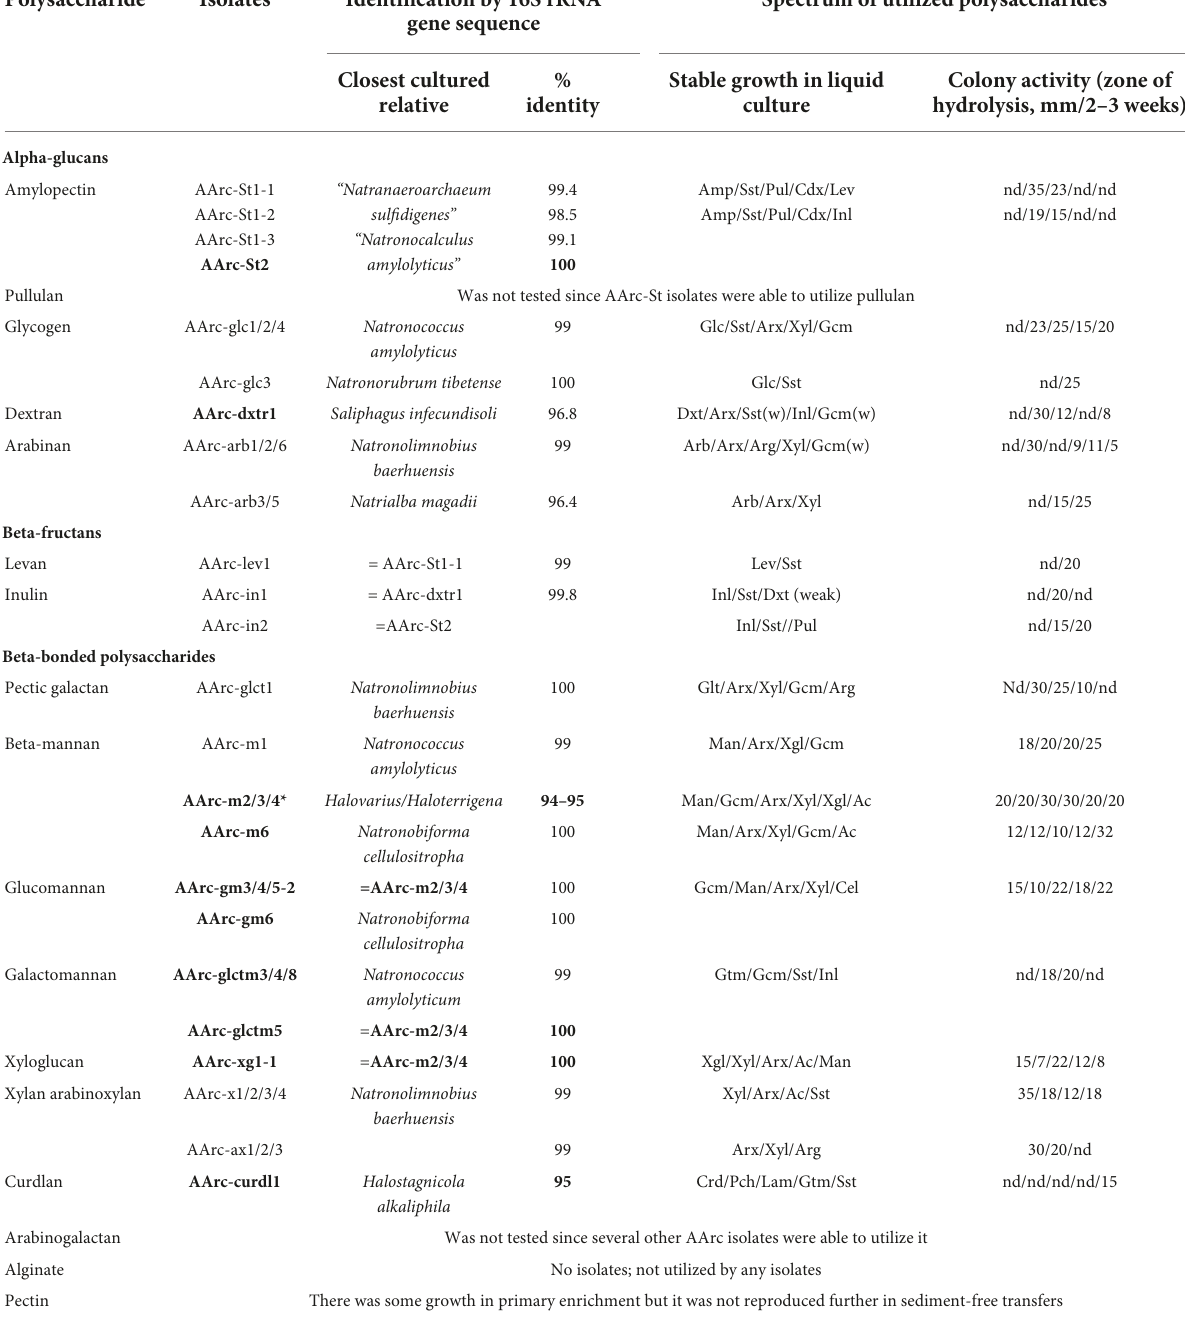
TABLE 2 Polysaccharide-utilizing natronoarchaea enriched and isolated from hypersaline soda lakes. Polysaccharide Isolates Identification by 16S rRNA